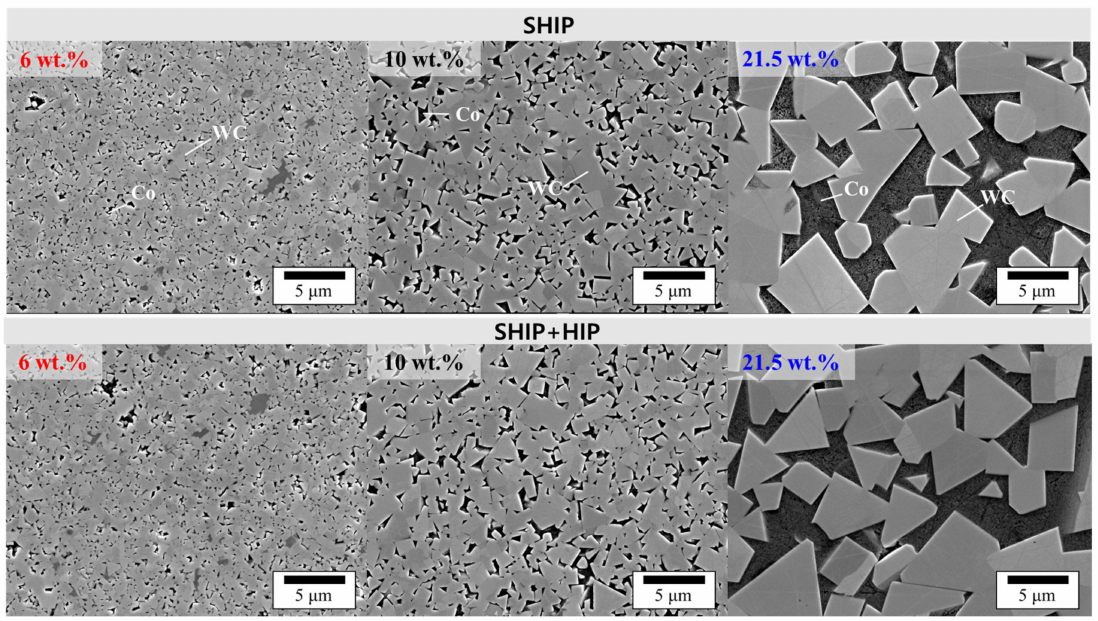
Figure 13. Comparison of SEM micrograph maps of WC-Co according to the Co content and HIP